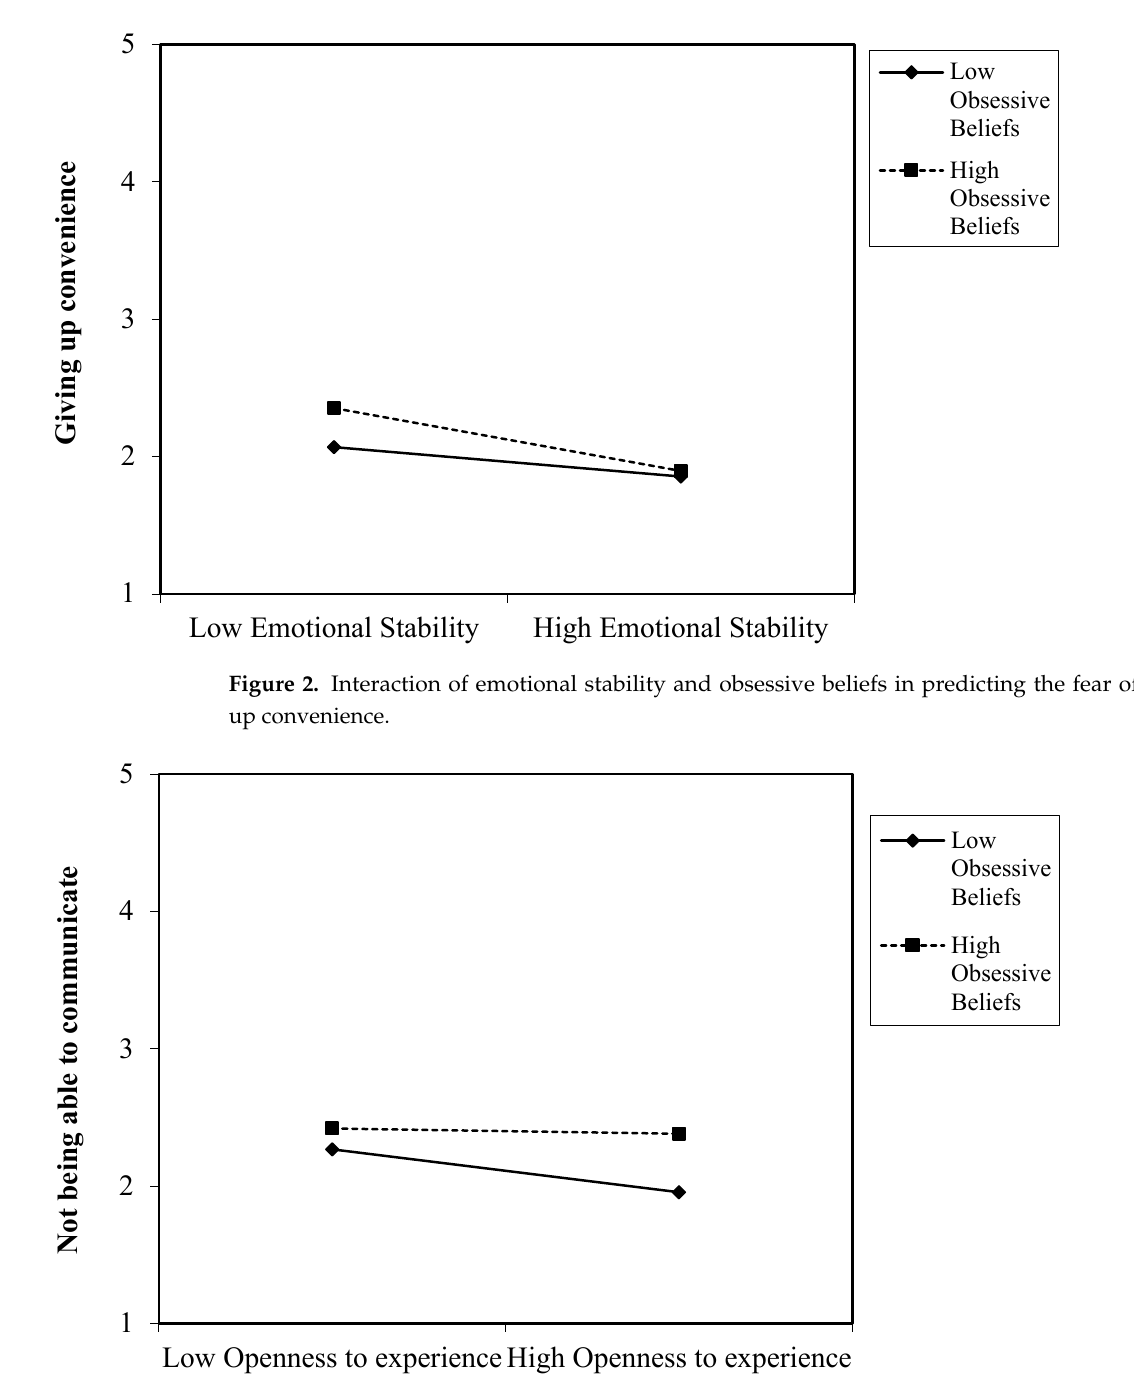
Figure 3. Interaction of openness to experience and obsessive beliefs in predicting the fear of not being able to communicate.